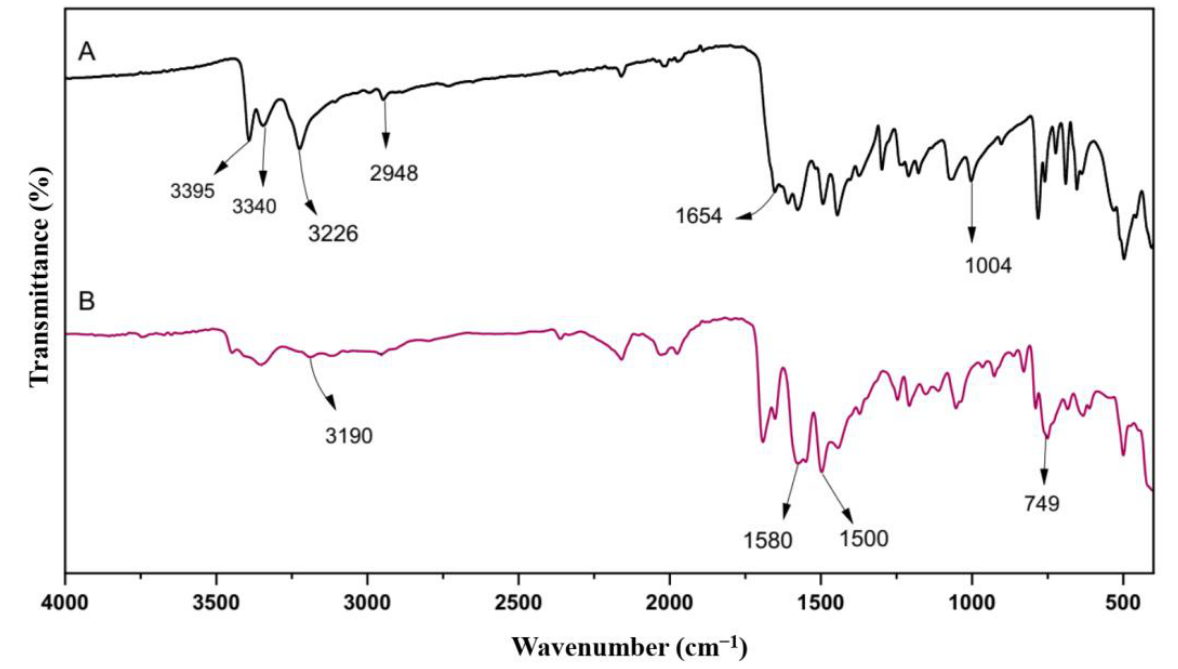
Figure 2. FTIR spectra of: (A) 6-amino-1,3-dimethyl uracil, and (B) 2Clph-BU. On the other hand, Figure 3 shows the FTIR spectra of Cs before and after modification. Between 3700 and 3000 cm − 1 , a very broad absorption peak was observed, corresponding to the peak of hydroxyl groups overlapping with that of -NH 2 groups and their hydrogen bonds. In this wavenumber range, there is a doublet peak at 3358 and 3297 cm − 1 related to the -NH 2 groups. The symmetric stretching vibration peaks of the -CH and -CH 2 groups in the moieties of pyranose appeared at 2916 and 2875 cm − 1 , respectively. Further, two weak peaks appeared at 1649 and 1577 cm − 1 attributable to amide I and amide II, respectively, confirming the high Cs deacetylation degree. The four absorption peaks that appeared at 1157, 1071, 1024, and 892 cm − 1 in the spectrum of FTIR of virgin Cs confirmed its saccharide moieties